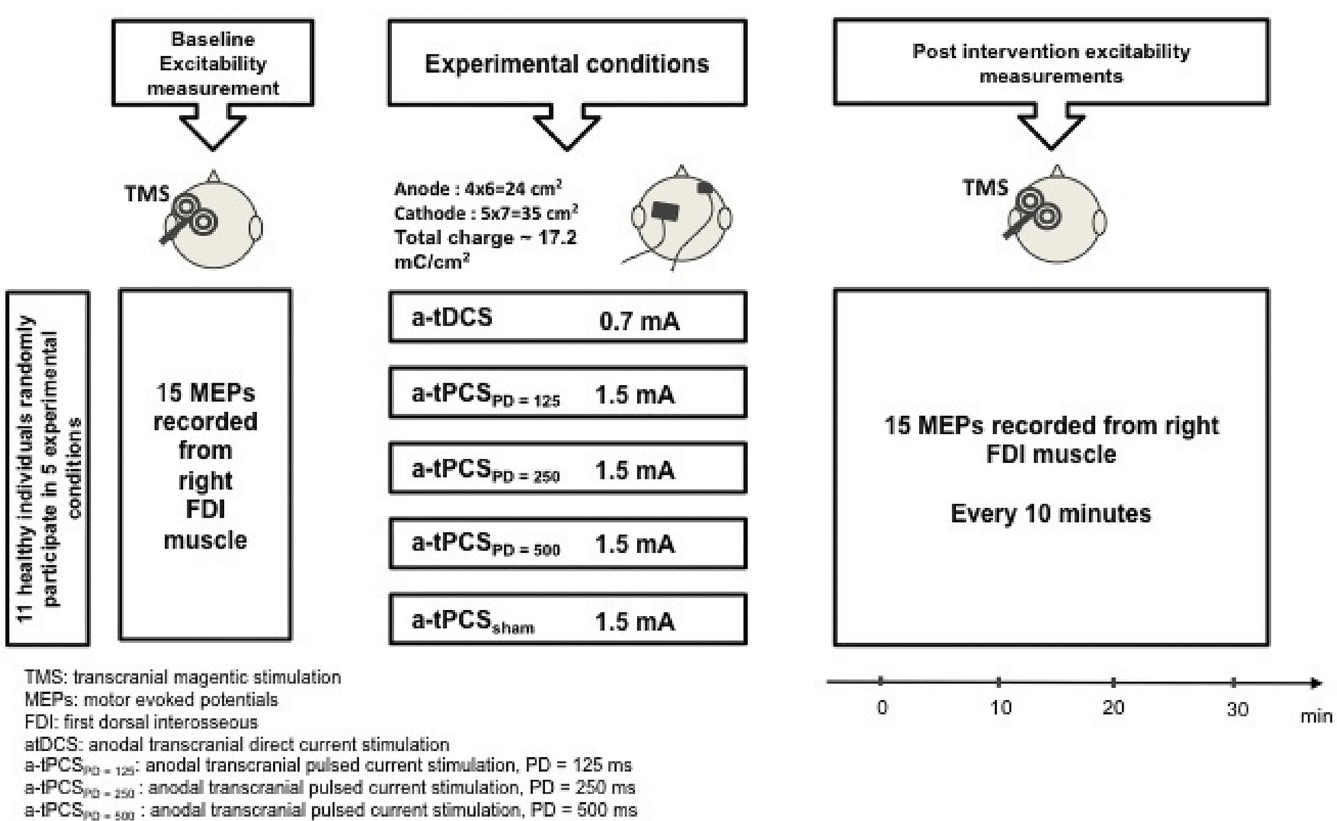
Fig 2. Study design for the comparison of different current types on